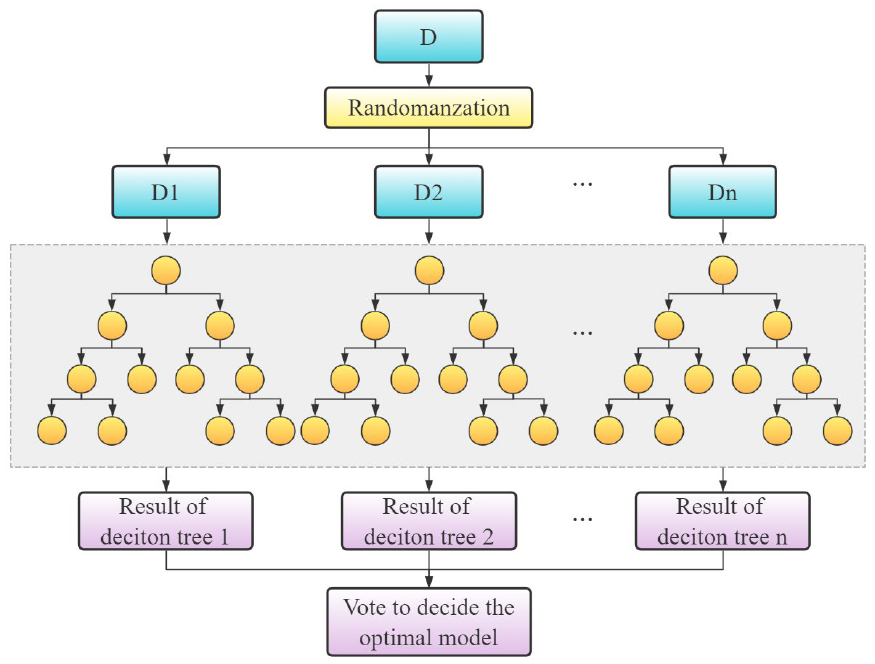
Figure 2. Random forest model establishment process .